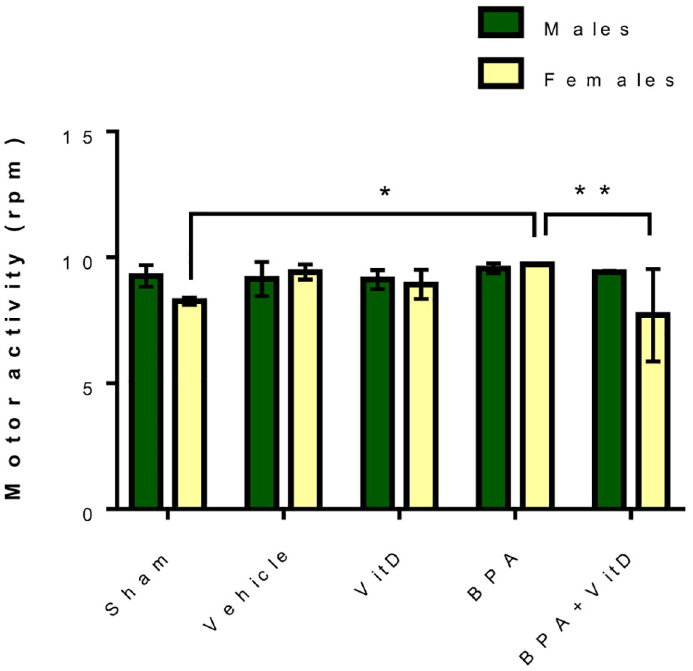
Fig 2. Effect of BPA and VitD on the motor activity in male and female mice. Data are represented as mean ± SD (n = 12), and P < 0.05 is represented as � and P < 0.01 is represented as �� .